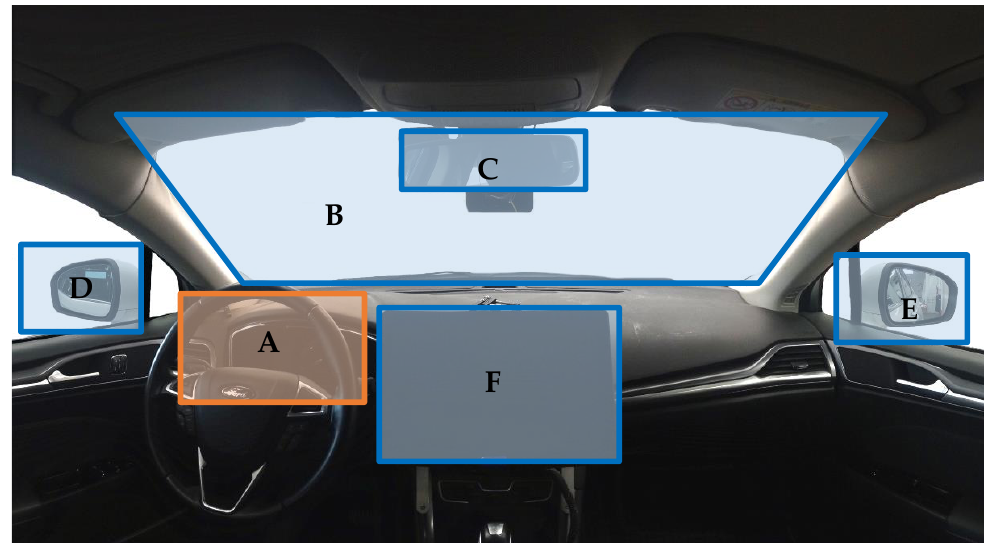
Figure 1. Areas of interest (AOI) in the experimental setup. A: dashboard; B: windshield; C: rear mirror; D: left mirror; E: right mirror; F: SURT Tablet. Only the dashboard AOI is used in analysis. The others were used for better evaluation of data validity.